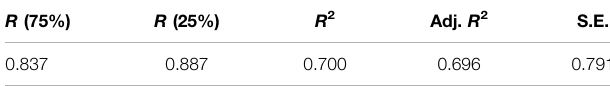
TABLE 13 | Multiple regression model summary (75% of data).